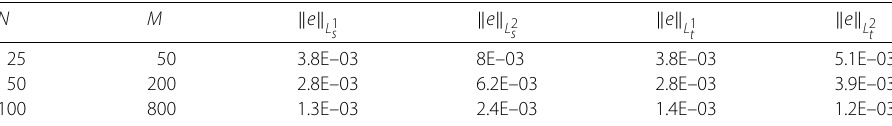
Table 2 Spatial and temporal error norms for SCFDM with α = 2 at t =